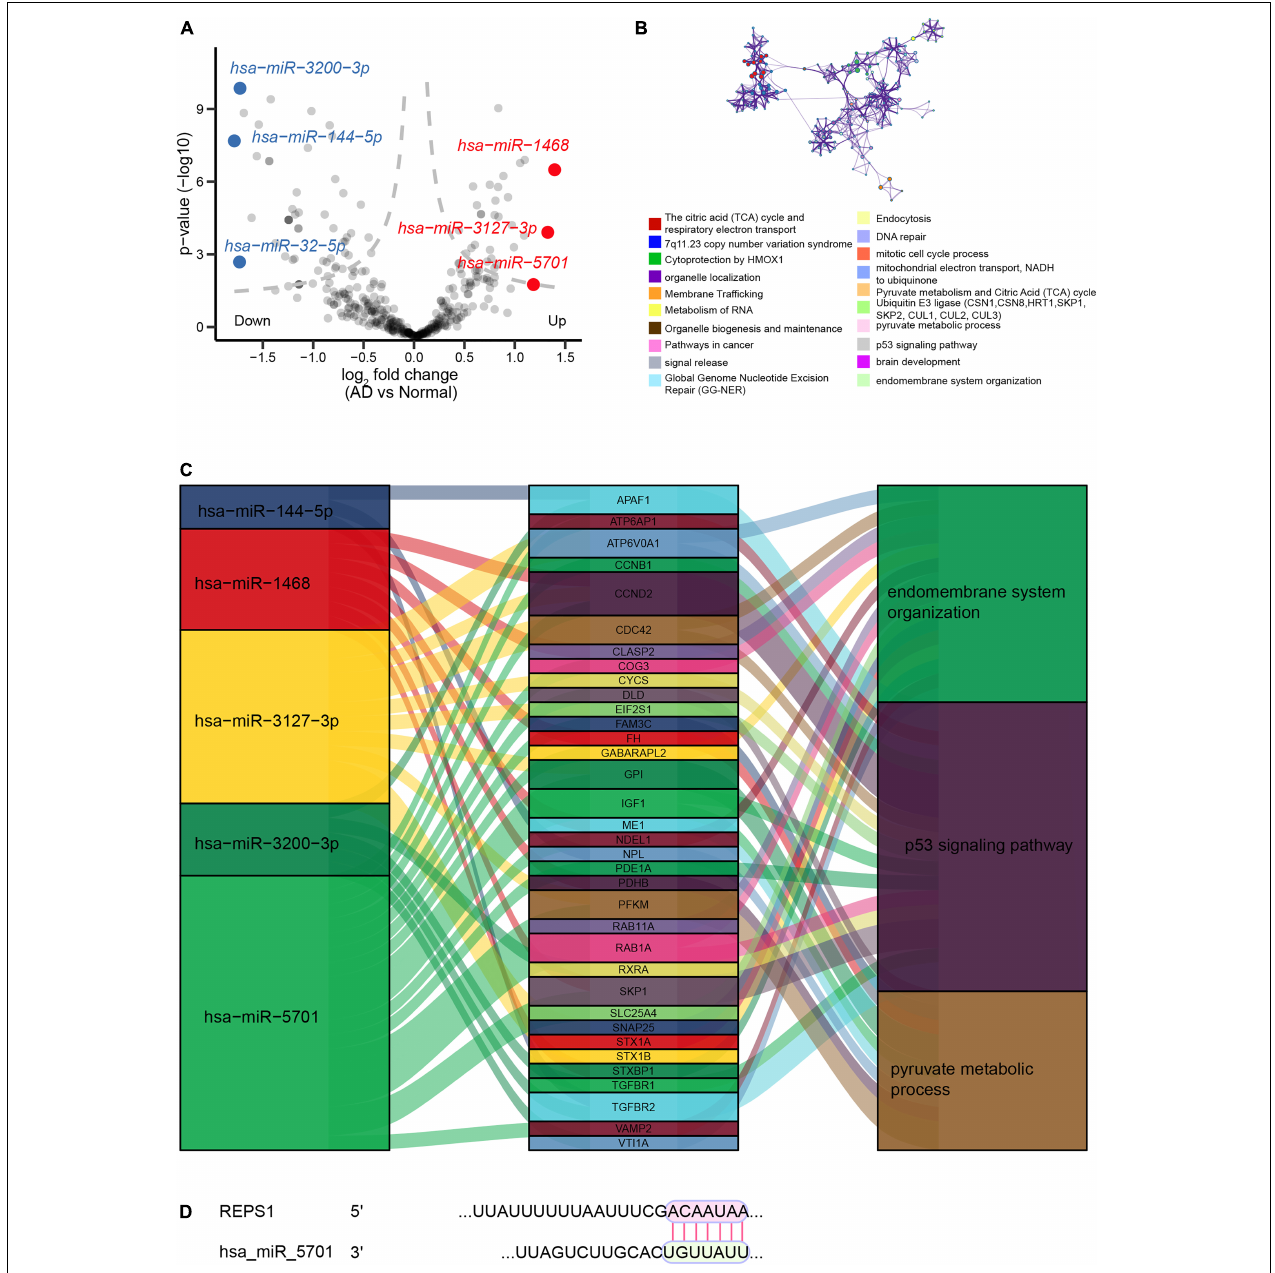
FIGURE 5 | Regulatory network of miRNAs in Alzheimer’s disease (AD). (A) Volcano plot of differentially expressed miRNAs between AD and controls in the dataset GSE46579. Red indicates the top three upregulated miRNAs, while blue indicates the top three downregulated miRNAs. (B) Enrichment analysis of the three differentially expressed miRNAs showing the largest | log 2 (fold change)| . (C) Sankey plots showing the biological functions potentially affected by the regulatory relationships between differentially expressed miRNAs and differentially expressed genes. (D) Predicted binding between REPS1 and hsa-miR-5701, based on